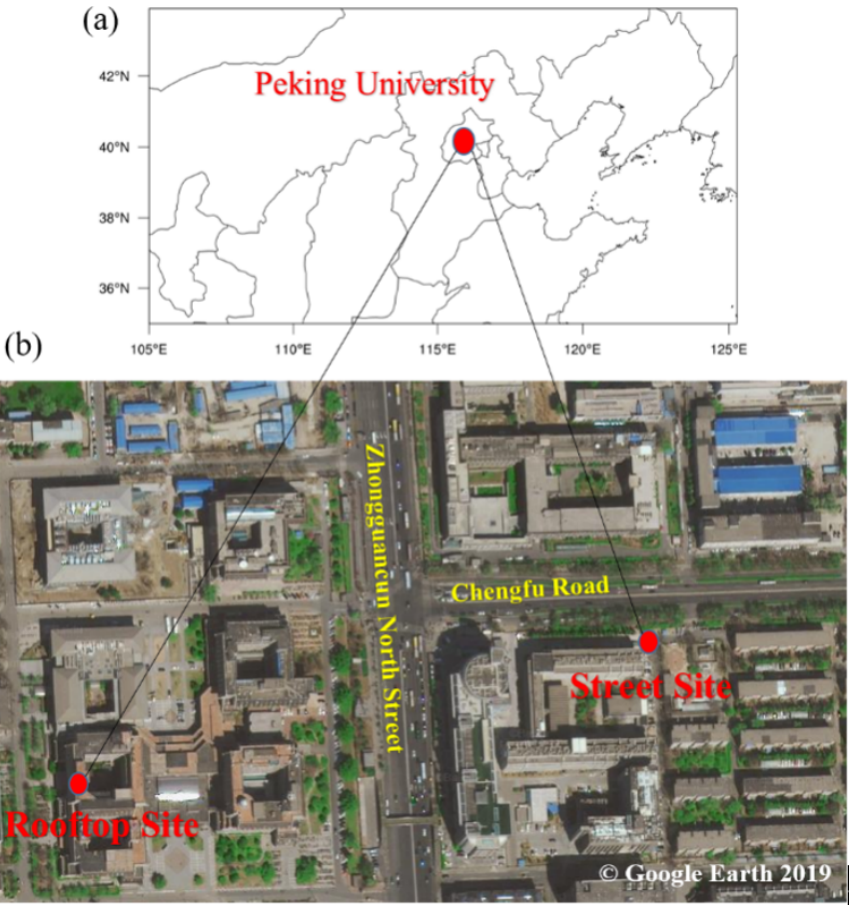
Figure 1. Locations of sampling sites (a) and satellite imagery of the two sampling sites (b) (downloaded from https://www.earthol.com/, last access: 23 December